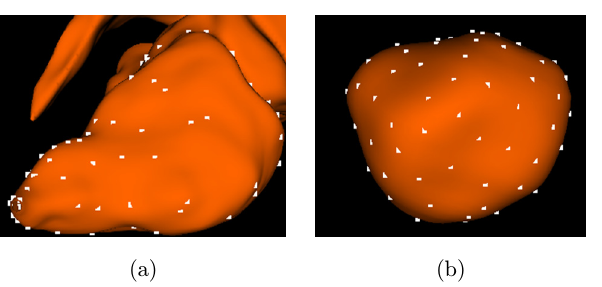
Fig. 7. Comparison of reconstruction error of di®erent methods.